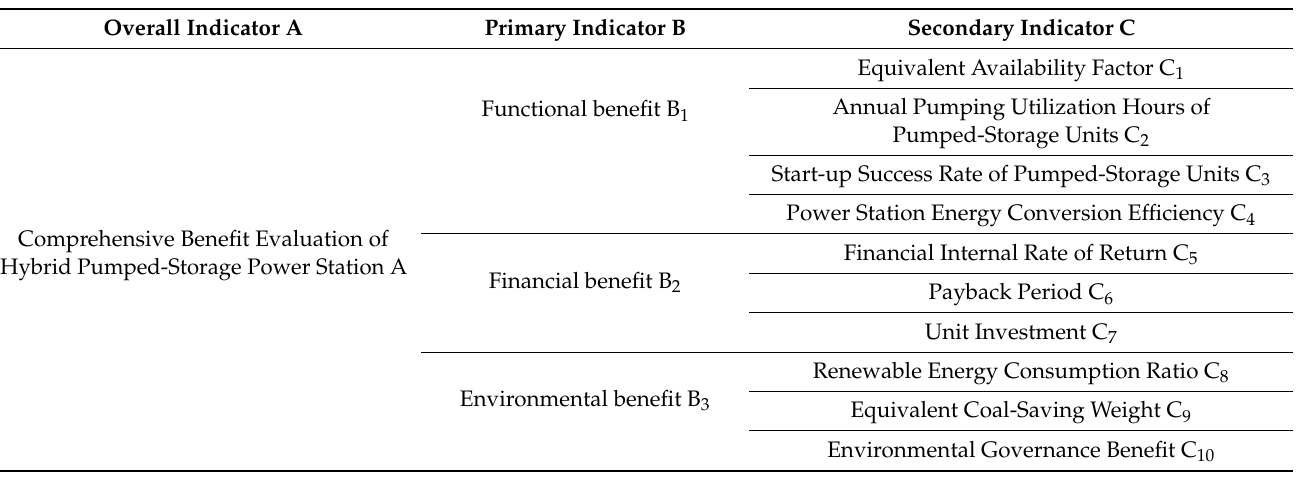
Table 1. Power station comprehensive benefit evaluation indicator